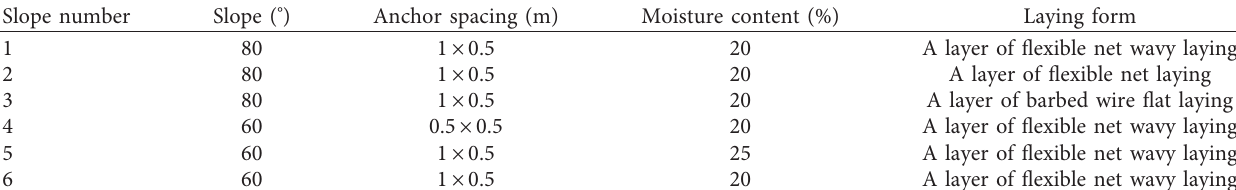
Figure 5: The test model layout. (a) 1-4 section test instrument. (b) 2-5 section test instrument. (c) 3-6 section test instrument. (d) Test model size (unit: cm). Table 2: The model